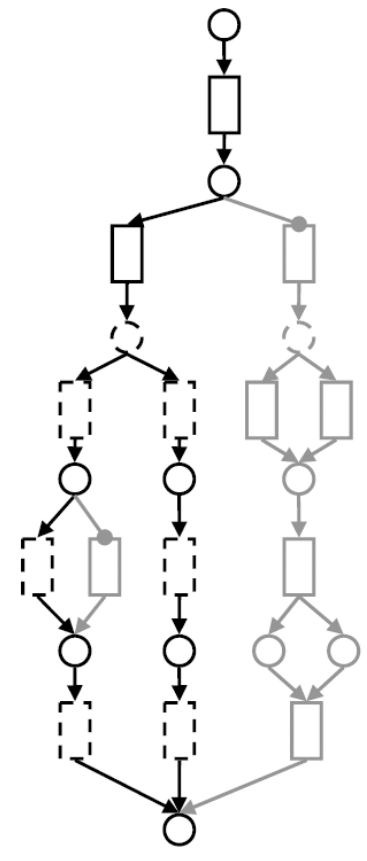
Fig. 6. Rough Transitions.